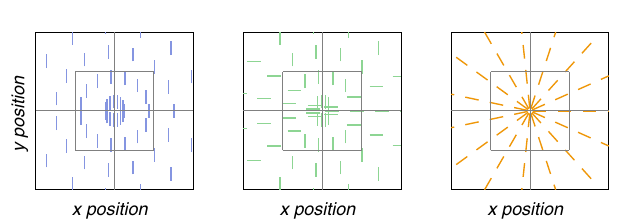
Fig. 4 | Schematic of three ideal orientation maps. Ideal maps of orientation preferenceare plottedinvisualspace.Eachline represents a single ideal voxel and is positioned at the voxel ’ s pRF center. The orientation of the line indicates the preferred orientation. Left, vertical map. Center, cardinal map. Right, radial